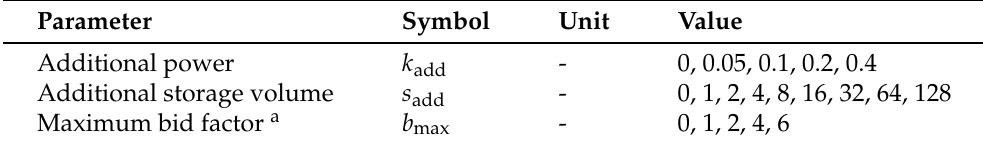
Table 1. Parameters of sensitivity